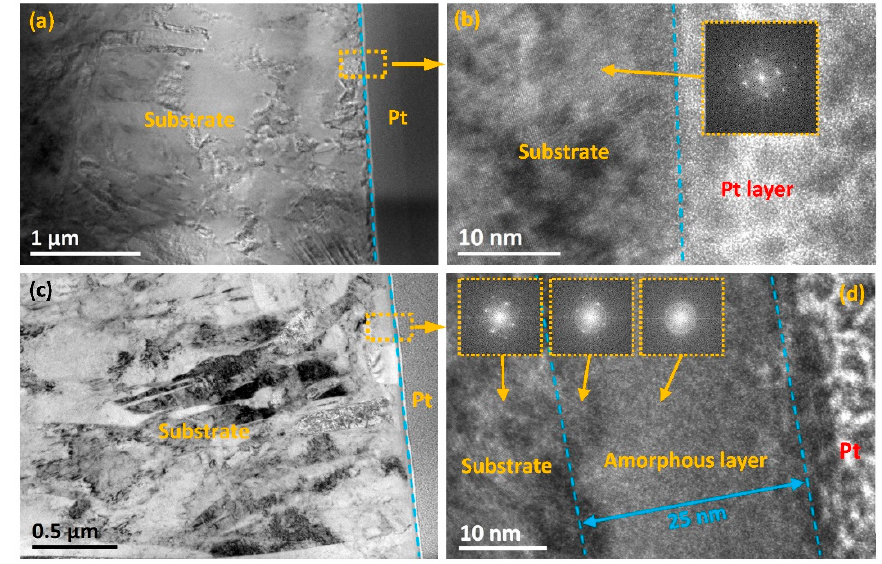
Figure 2. Transmission electron microscopy (TEM) cross-sectional images of ( a , b ) S0, ( c , d ) S1.